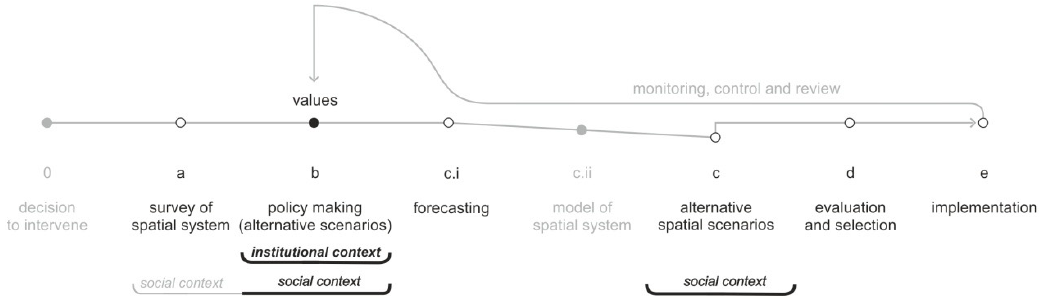
Figure 8. The elements of advocacy land-use planning, according to Davidoff [20], in diagrammatic form, with the comprehensive model’s components in the background. White circle: coincidence with McLoughlin’s component. Gray circle: lack of the corresponding McLoughlin component. Dark circle: the central component, also included in McLoughlin’s components. Below the axis: contextual factors.